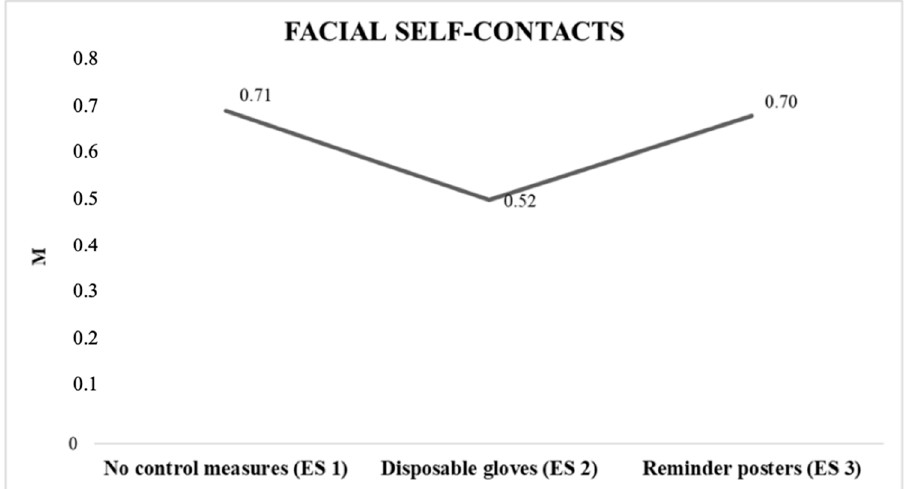
Figure 1. Average number of self–contacts per minute in the different experimental situations. Note: ES = experimental situation. ES 1 (no control measures), ES 2 (disposable gloves), ES 3 (reminder